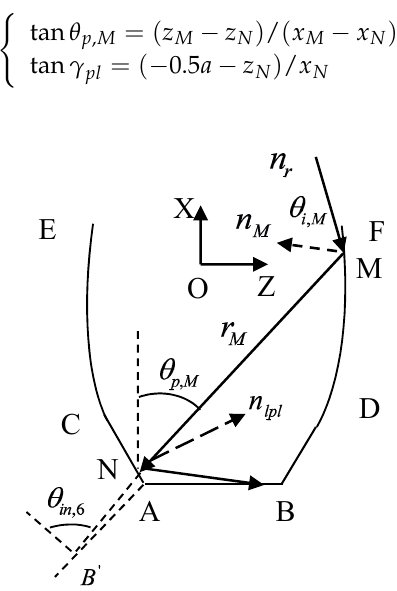
Figure 10 . Critical angle Figure 10. Critical angle θ p , c 2 and critical point K for θ p > θ a .